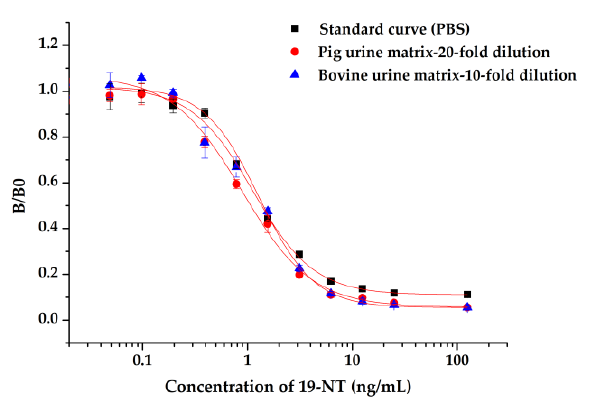
Figure 10. Sample matrix extracts of ic-ELISA. Table 3. Recovery Analysis of 19-NT in the Spiked Samples by ic-ELISA.